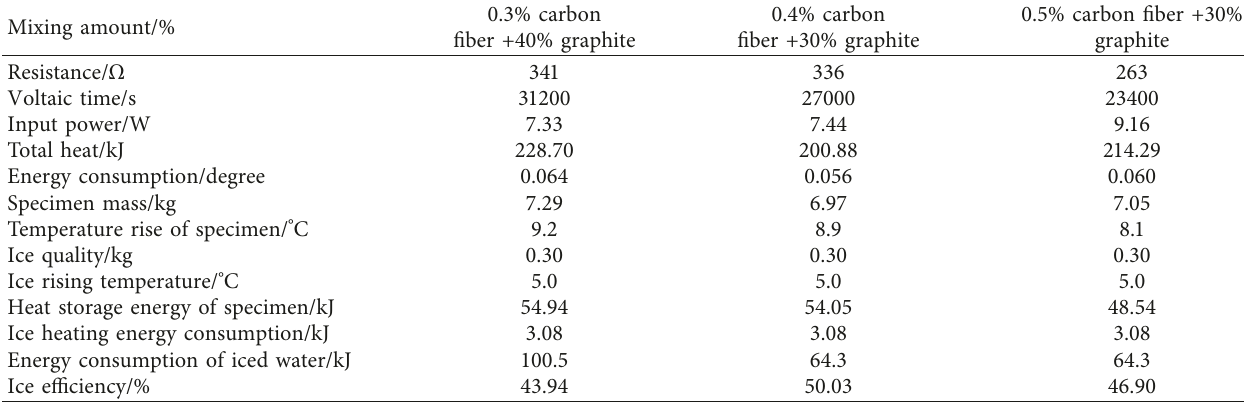
Table 16: Heating and melting efficiency of rutting board.